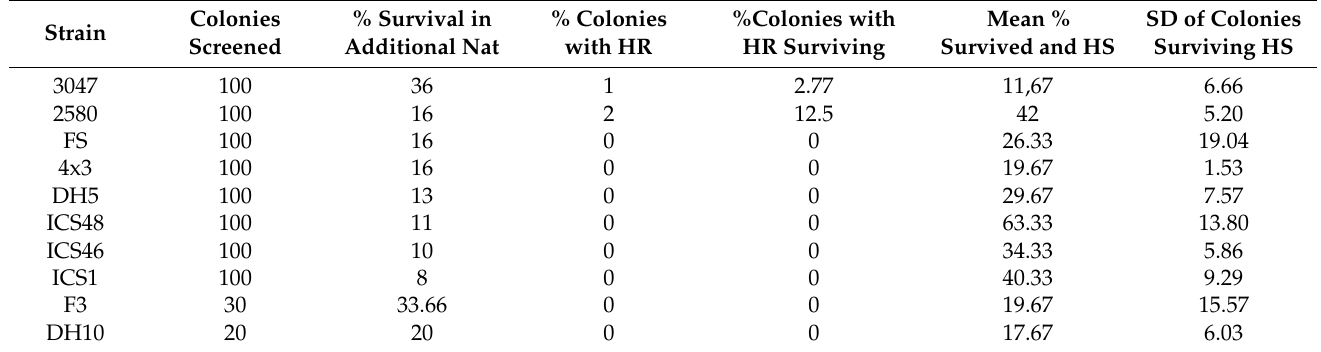
Table 3. Homologous recombination (HR) rates of 10 different M. pulcherrima strains when targeting URA3 and their survivability after the heat shock (HS) that takes place during the transformation